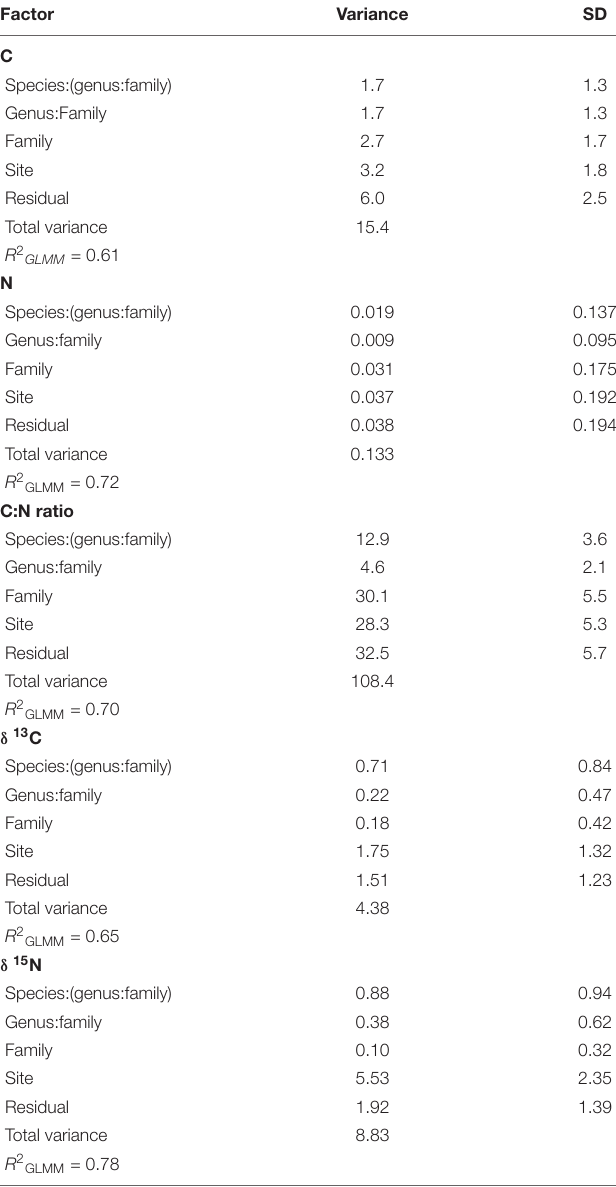
TABLE 1 | Variance partitioning according to taxonomy (nested design: family/genus/species), site, and residual for foliar C, N, C:N ratio, δ 13 C, and δ 15 N.